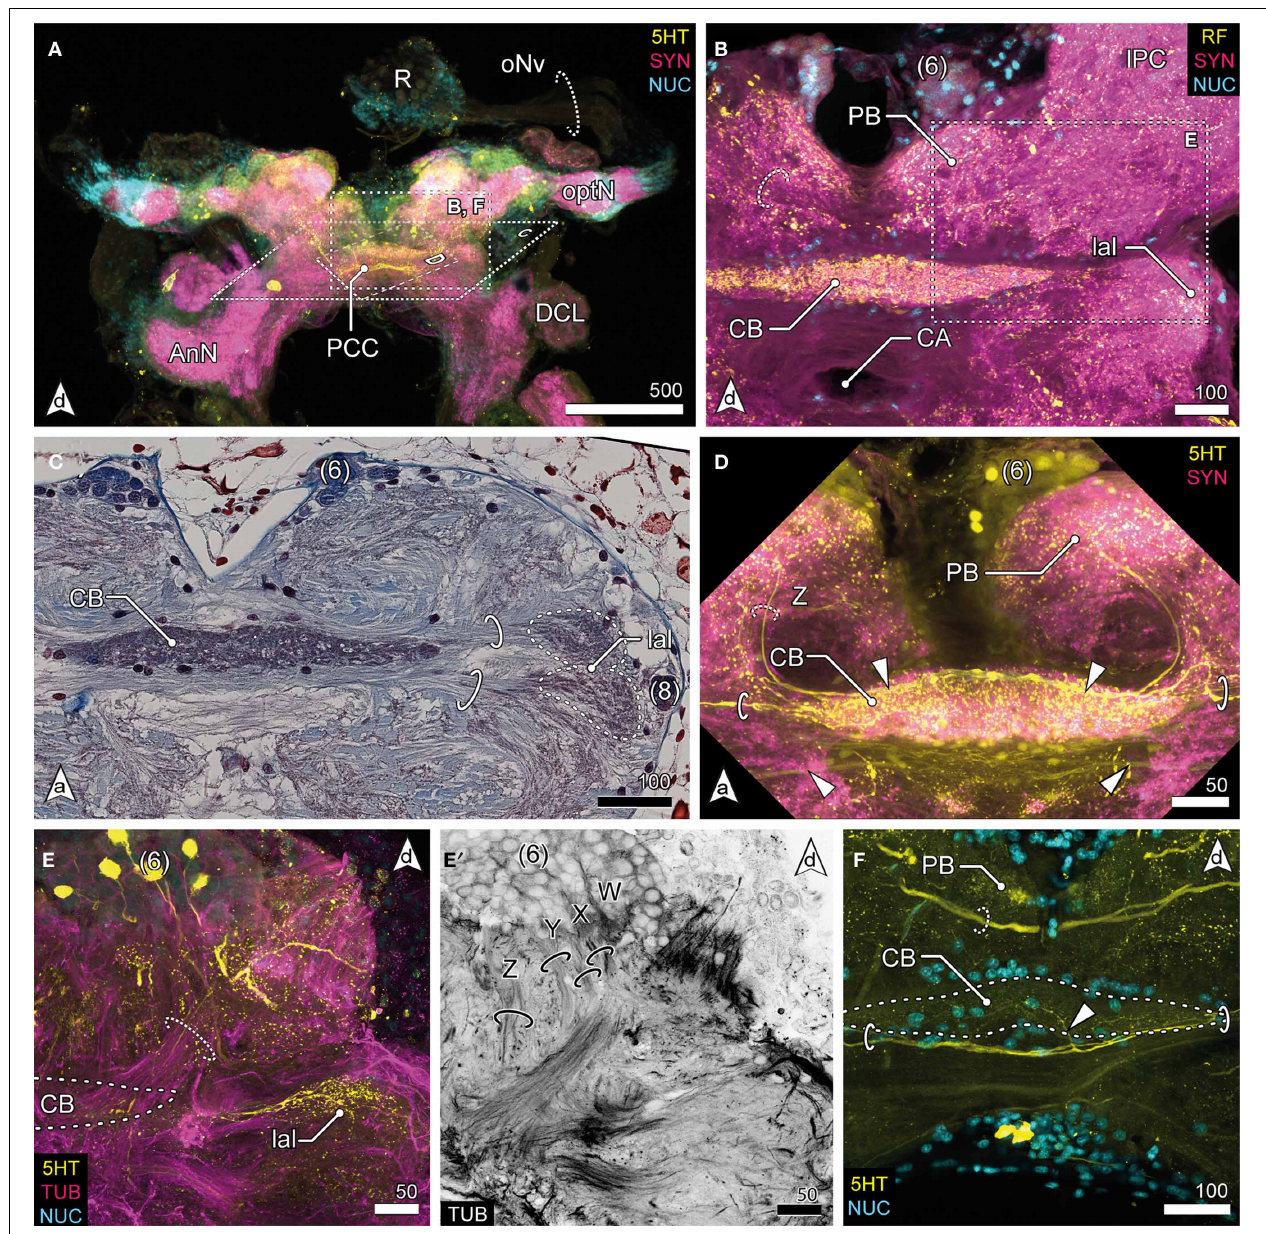
FIGURE 4 | Median protocerebrum and central complex. (A) Overview of the brain from posterior. A large 5HTir PCC connects both hemispheric lPC ventrally to the CB. (B) The central complex labeled against RF-amides showing the anterodorsal cluster 6, the PB, CB and lal, frontal section. The CB is ensheathed by a couple of somata, none of which showing RFir (compare with F ). The PB is interconnected by a commissure (dotted circle). (C) Ventral extensions of (6) and (8), CB and lal. A couple of somata are distributed around the CB. The bipartite lal are interconnected by two large commissures (solid circles), horizontal paraffin section. (D) Frontal section of CB. 5HTir of commissures